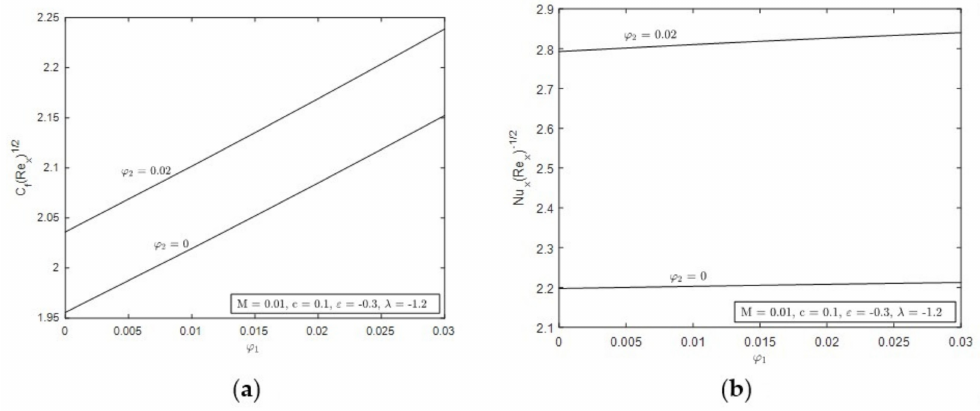
Figure 6. ( a ) Variation of C f with ϕ 1 for different values of ϕ 2 . ( b ) Variation of Nu x with ϕ 1 for different values of ϕ 2